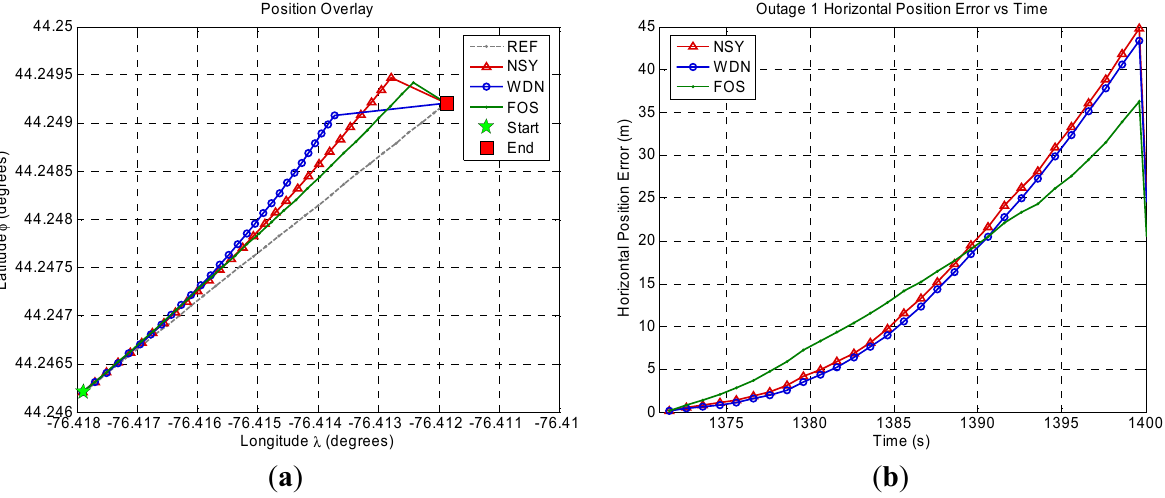
Figure 8. Land vehicle experiment position domain results for GPS outage 1. ( a ) Position domain plot. ( b ) Horizontal position error plot.